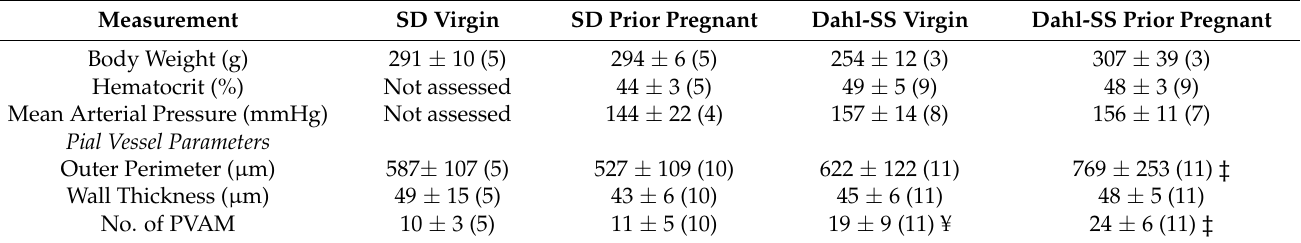
Table 1. General and vascular characteristics of